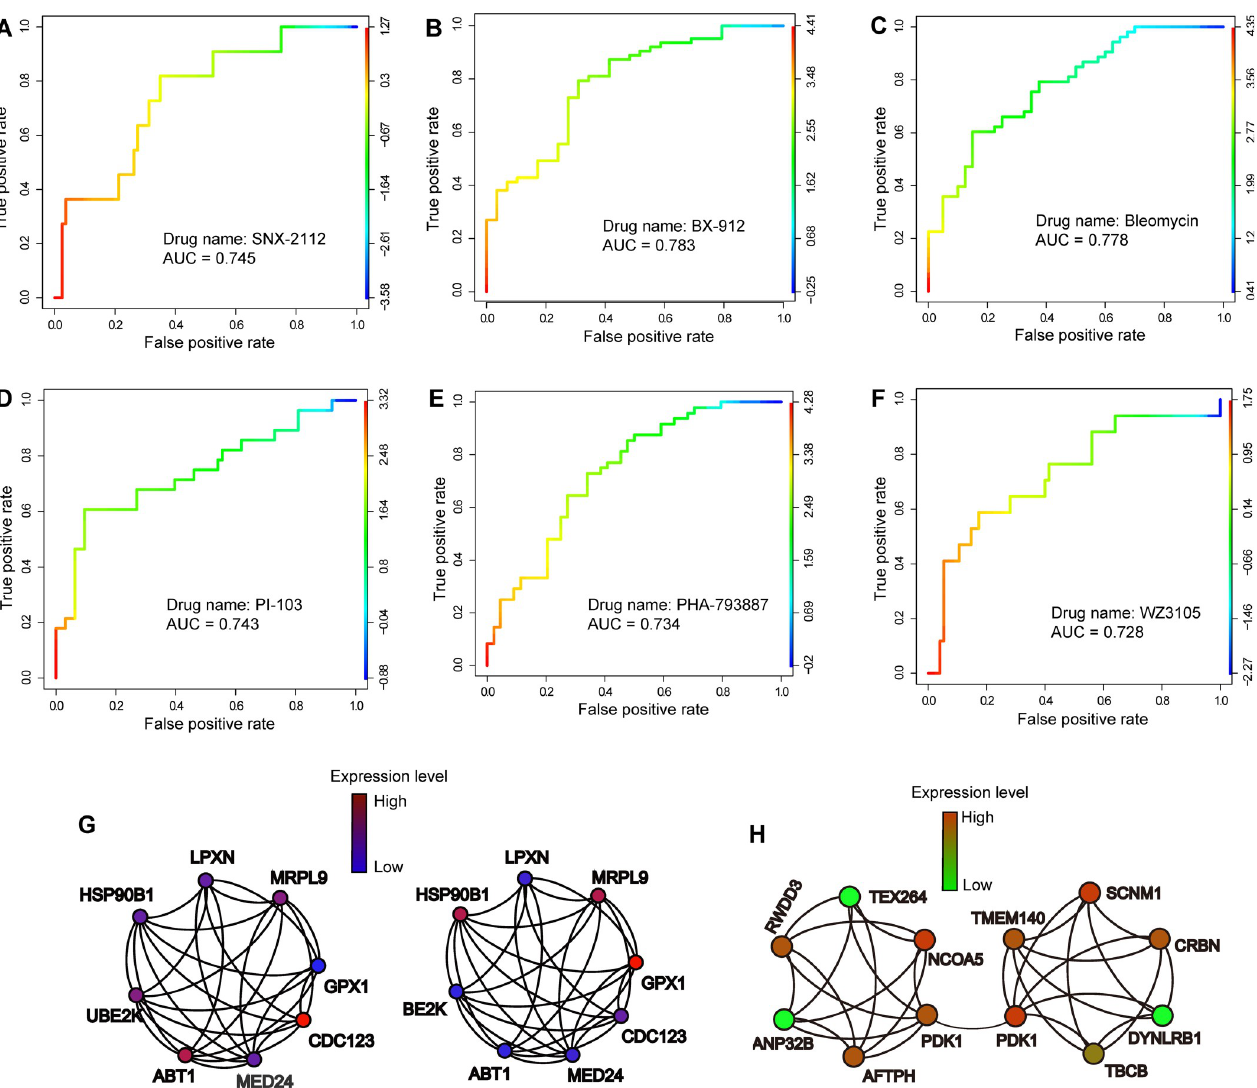
Fig 5. Cancer pharmacogenomics validation for COAC-predicted gene subnetworks. ( A to F ) The receiver operating characteristic (ROC) curves for six selected drugs: SNX-2112 (a selective Hsp90 inhibitor), BX-912 (a PDK1 inhibitor), Bleomycin (induction of DNA strand breaks), PHA-793887 (a pan-CDK inhibitor), PI-103 (a PI3K and mTOR inhibitor), and WZ3105 (also named GSK-2126458 or Omipalisib, a PI3K inhibitor). Drug IC 50 values were predicted based on SVM regression models built by utilizing the COAC-inferred gene subnetworks as feature vectors (see Methods). The area under ROC curves (AUC) during 10-fold cross-validations were shown. In each ROC plot, the cutoff values at the corresponding curve positions are represented by the color keys. ( G and H ) Two COAC-inferred gene co-expression subnetworks for two selected drug targets on SNX-2112 ( G ) and BX-912 ( H ). The color key of each node indicates the weight of the genes in each